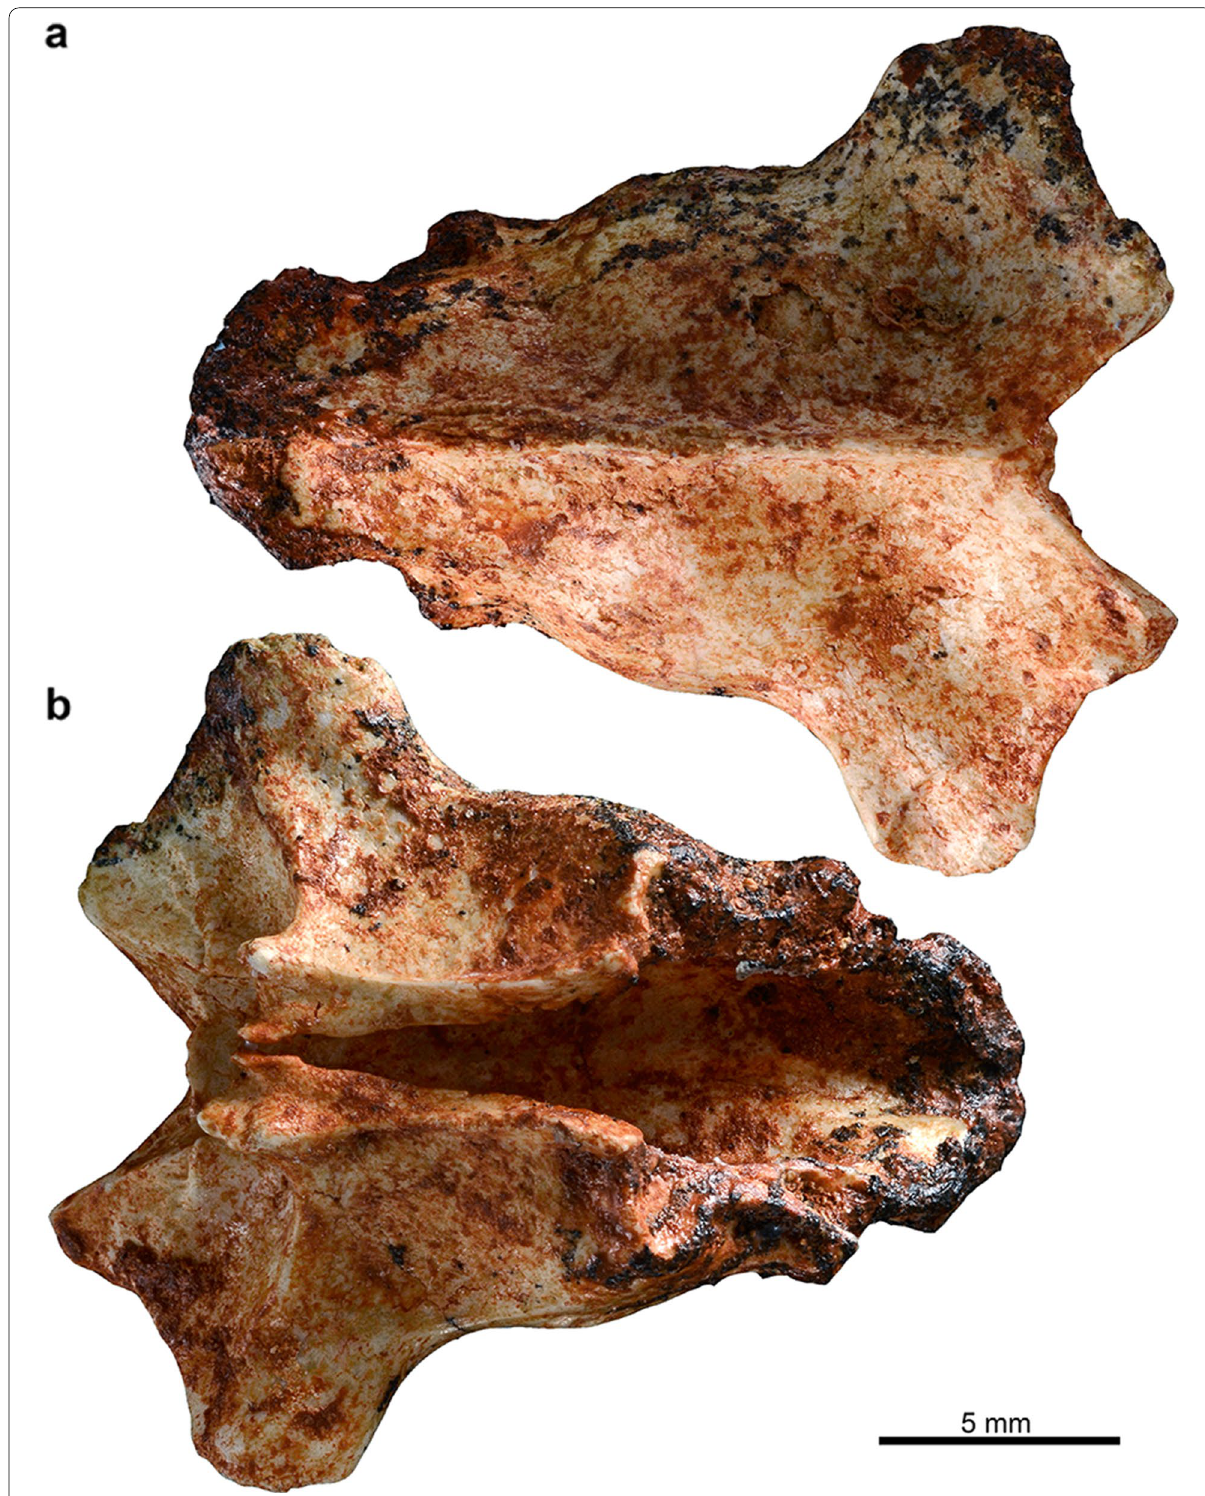
Fig. 103 Phosphoroboa filholii comb. nov. from the late Eocene of Escamps A, Phosphorites du Quercy: parietal (UM ECA 2543) in dorsal ( a ) and ventral ( b )